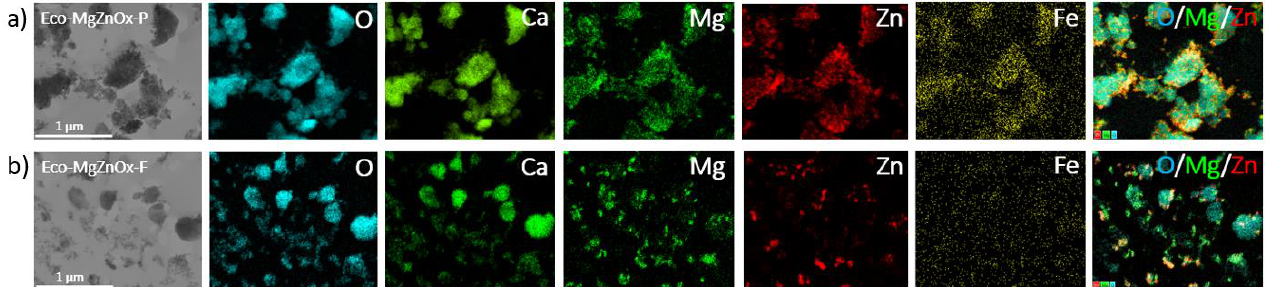
Figure 2. STEM-bright field images of ( a ) Eco-MgZnOx-P and ( b ) Eco-MgZnOx-F. Oxygen, calcium